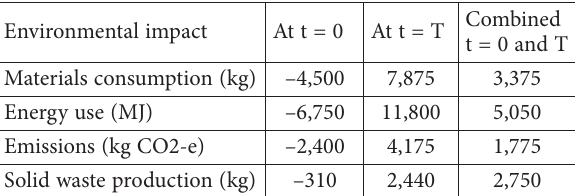
Figure 3. Unit processes and inventory flows for the LCA Table 3. Differences (NA - A) in environmental